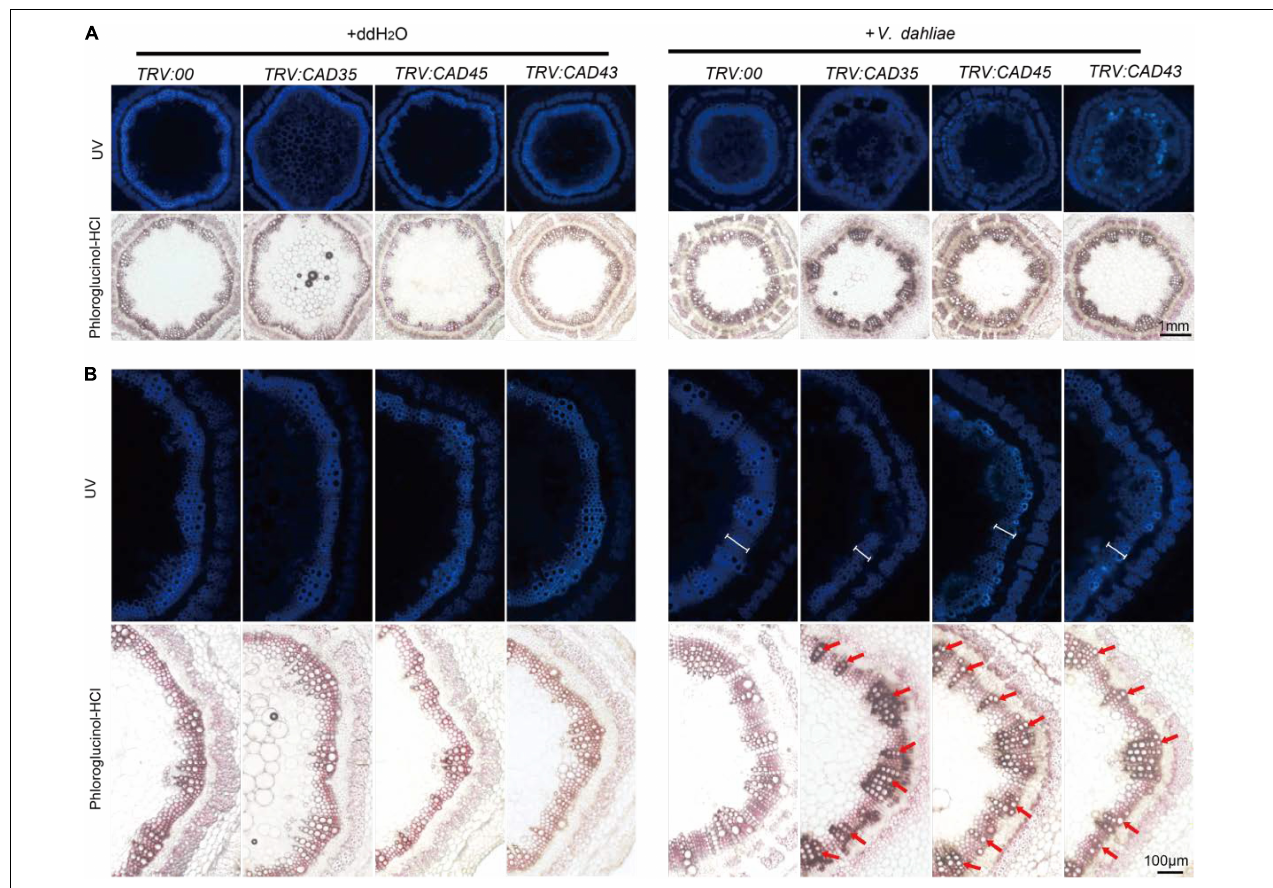
FIGURE 7 | Histochemical analyses of lignin in the stem cross-sections from TRV:00 , TRV:CAD35 , TRV:CAD45 , and TRV:CAD43 VIGS plants at 18 dpi. (A) The handcut stems were illuminated by UV or stained with phloroglucinol-HCl to detect lignin. (B) Close-up of UV autofluorescence and phloroglucinol-HCl stain of stems corresponding to images in A. Two-weeks-old VIGS plants were inoculated with V. dahliae at an inoculum of 1 × 10 7 spores/mL using the root-dipping method. Scale bars in A and B represent 1 mm and 100 µ M, respectively. The white scales in V. dahliae inoculated stems under UV indicate the width of xylem; the red arrows indicate the